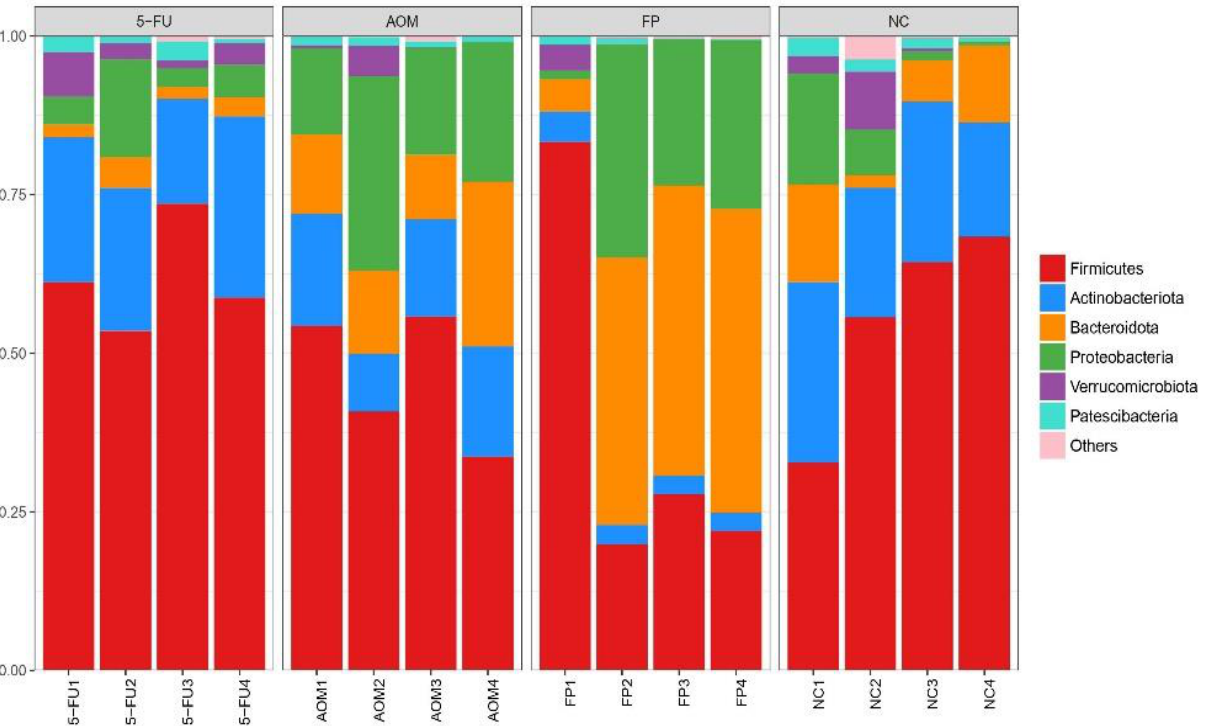
Figure 4. Plot of microbial diversity analysis at the phylum level. (NC): Normal control group, (AOM): azoxymethane group, (FP): F. prausnitzii group, (5FU): 5-fluorouracil group.